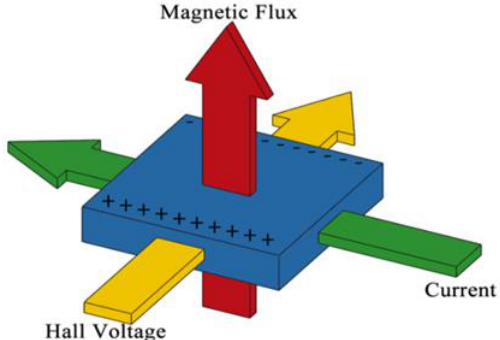
Figure 1. Schematic illustration of Hall effect.